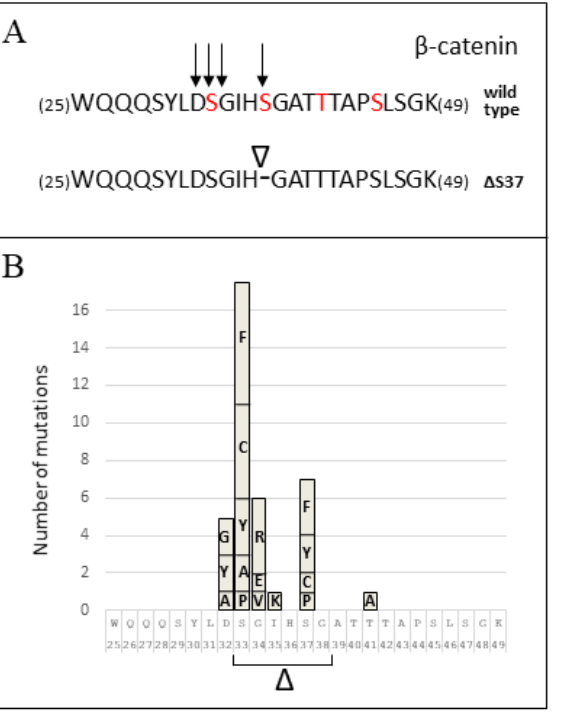
Figure 3. CTNNB1 mutation distribution in medulloblastoma and functional characterization of the β -catenin ∆ S37 variant. ( A ): The top line shows β -catenin amino acid composition between residues 25–49. Arrows indicate β -catenin residues mutated in our cohort of 88 pediatric medulloblastoma. Residues in red are regulatory phosphorylated residues. The bottom line shows the novel p.Ser37del β -catenin variant ( ∆ S37) found. Amino acids are denoted using the one-letter code. ( B ): The plot showing the identity and number of CTNNB1 mutations found in pediatric medulloblastoma. Data are from Saint Jude pecan database.